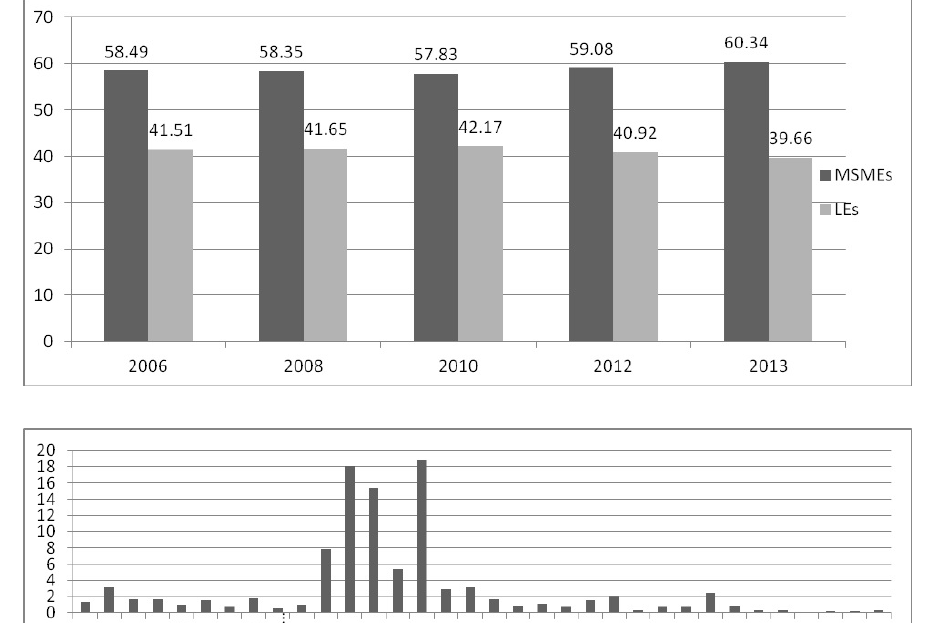
Figure 5. Percentage distribution of total MSEs using internet by province, Indonesia, 2016.